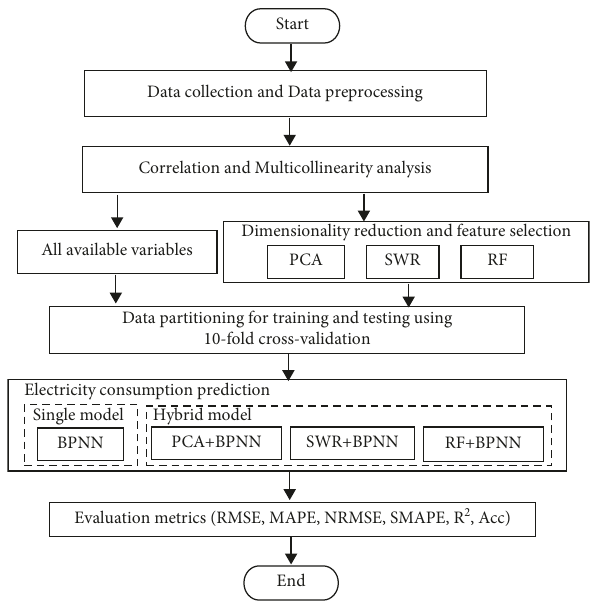
Figure 1: The framework of the hybrid machine learning model for electricity consumption